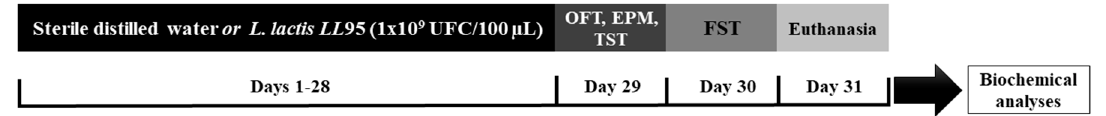
Figure 1. Experimental procedure. Abbreviations: OFT, Open-Field Test; EPM, Elevated Plus Maze; TST, Tail Suspension Test; FST, Forced Swim Test.